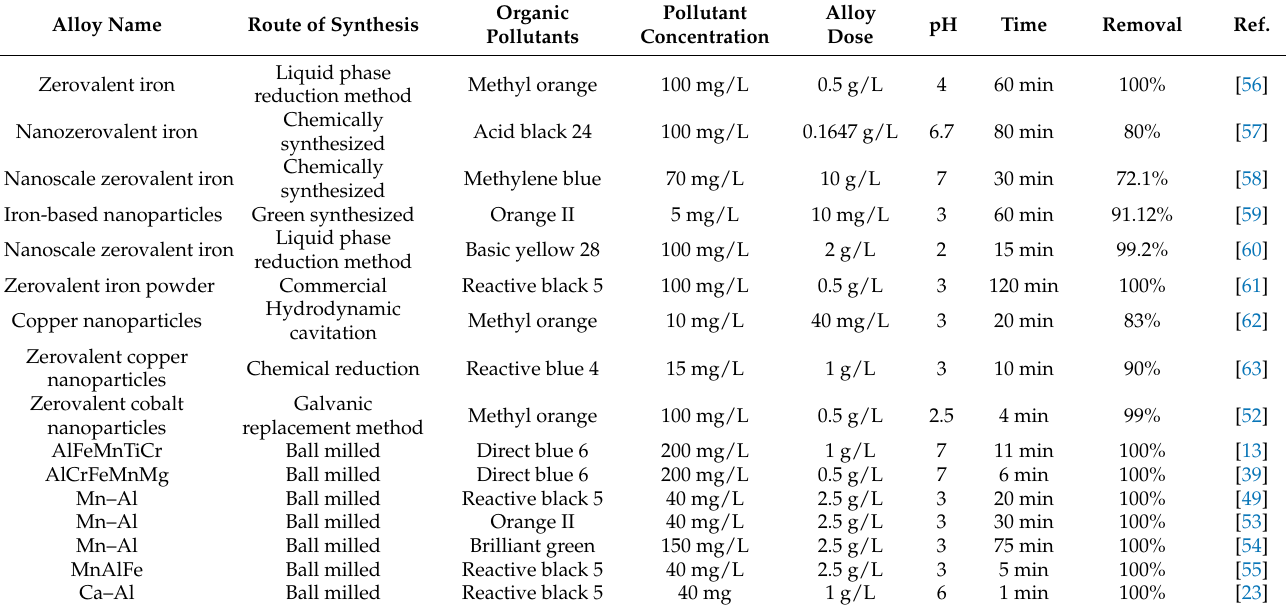
Table 1. List of some nanoreductive materials used in the removal of organic